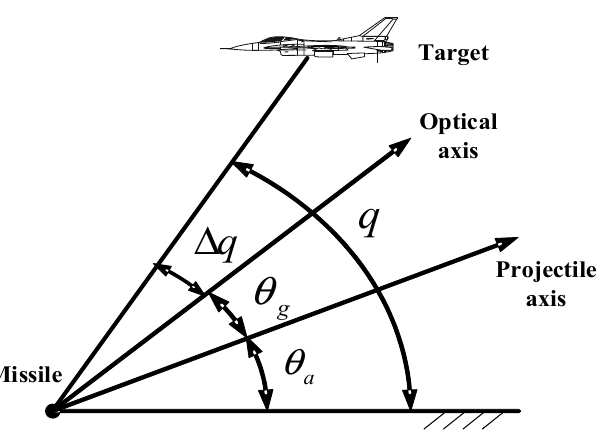
Figure 2. Angle relationship of radar seeker tracking.